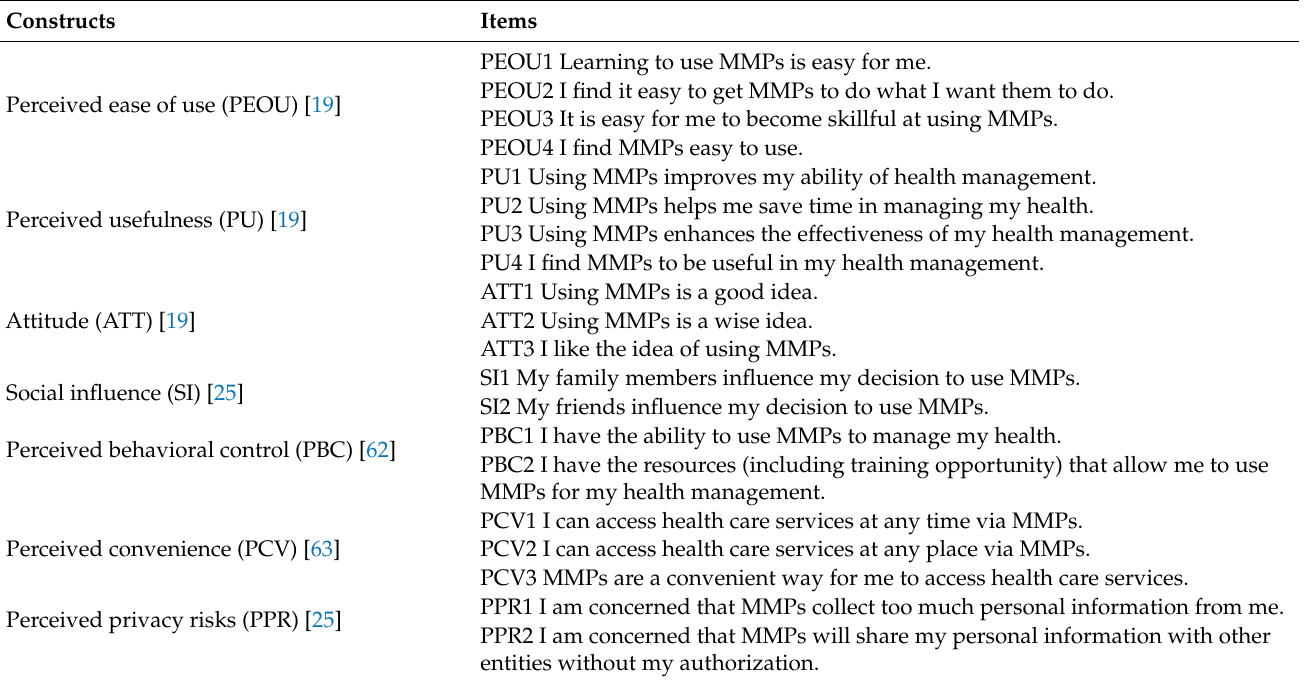
Table 2. Measurement items for the constructs in the research